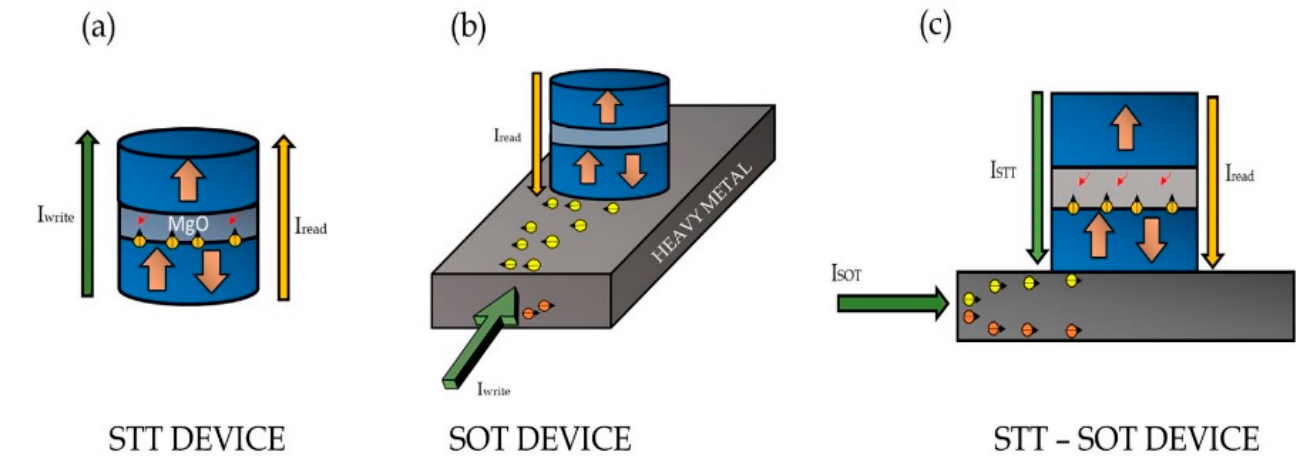
Figure 1. A schematic of the ( a ) spin-transfer torque (STT) device ( b ) spin-orbit torque (SOT) device and ( c ) STT-SOT device.